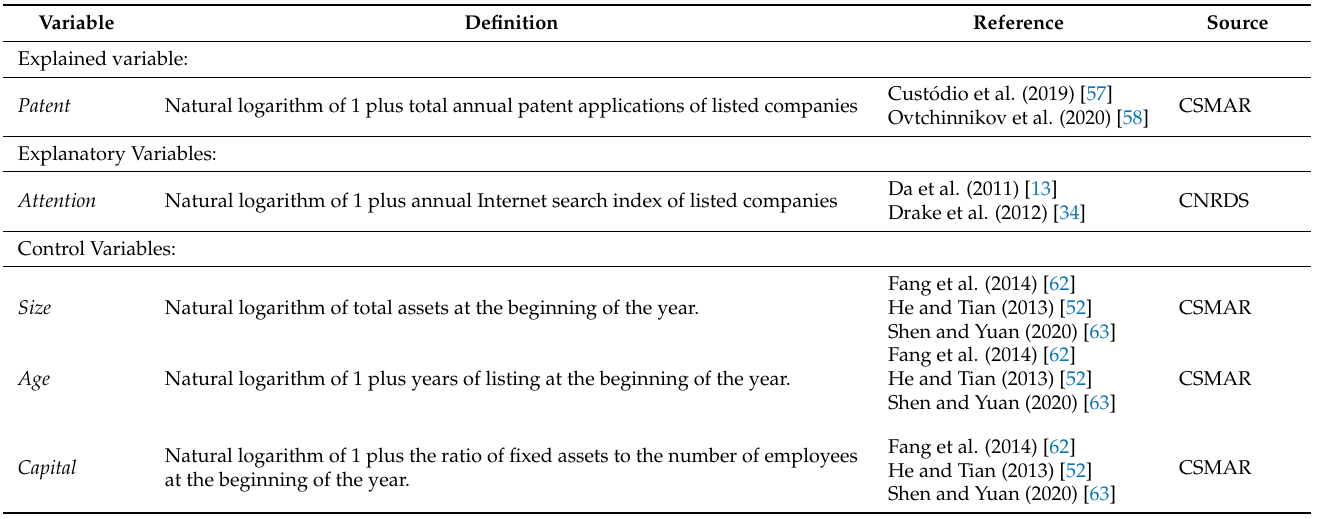
Table A1. Variable